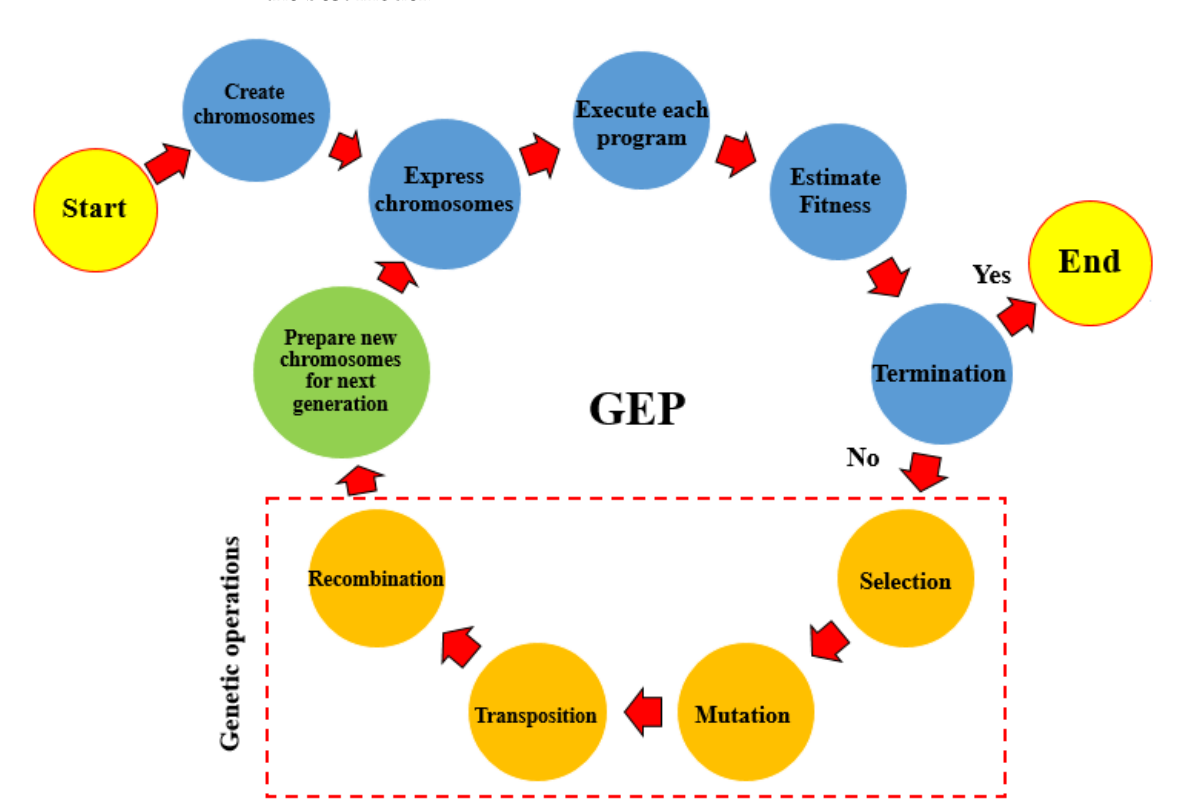
Figure 4. A two-gene chromosome illustrated in the form of tree codification.